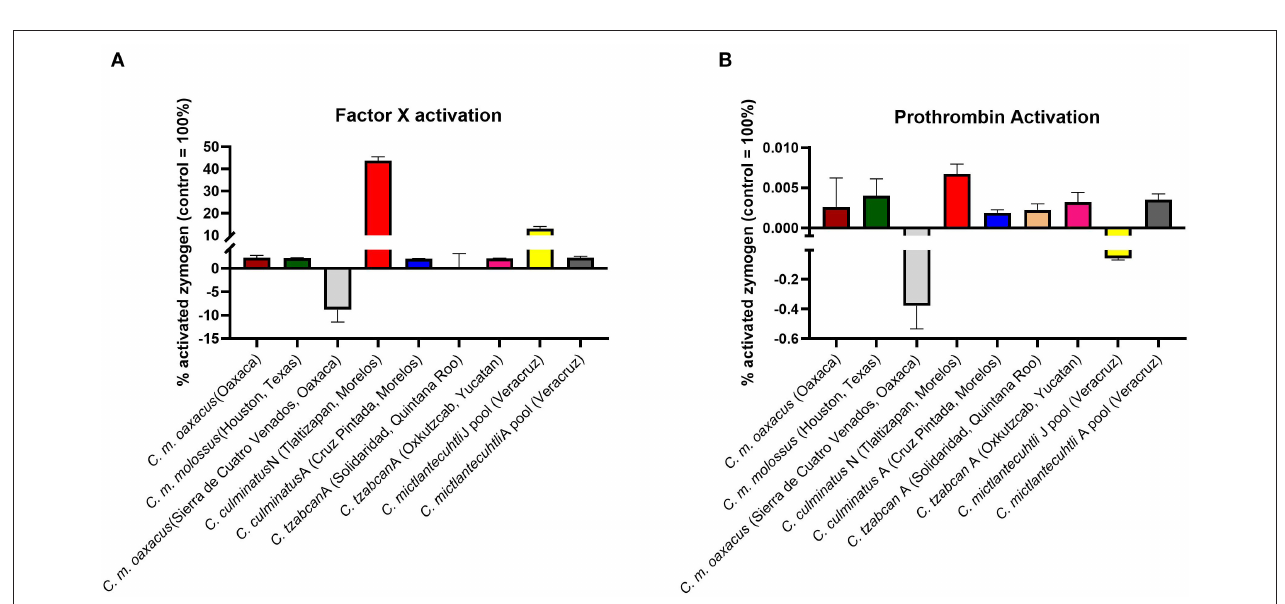
FIGURE 8 | Thromboelastography traces showing the fibrinogenolytic action of venoms from C. tzabcan (Oxkutzcab) and C. m. oaxacus (Sierra de Cuatro Venados). Venom traces are shown in red, spontaneous and thrombin control traces in blue. SP, split point (min); R, time (min) to minimum detectable clot (2mm); MA, maximum amplitude (mm); MRTGG, maximum rate of thrombus generation (dynes/cm 2 ); TMRTGG, time to maximum thrombus generation (min); TGG, total thrombus generation (dynes/cm 2 ). Results shown as n = 4 mean ± SD.